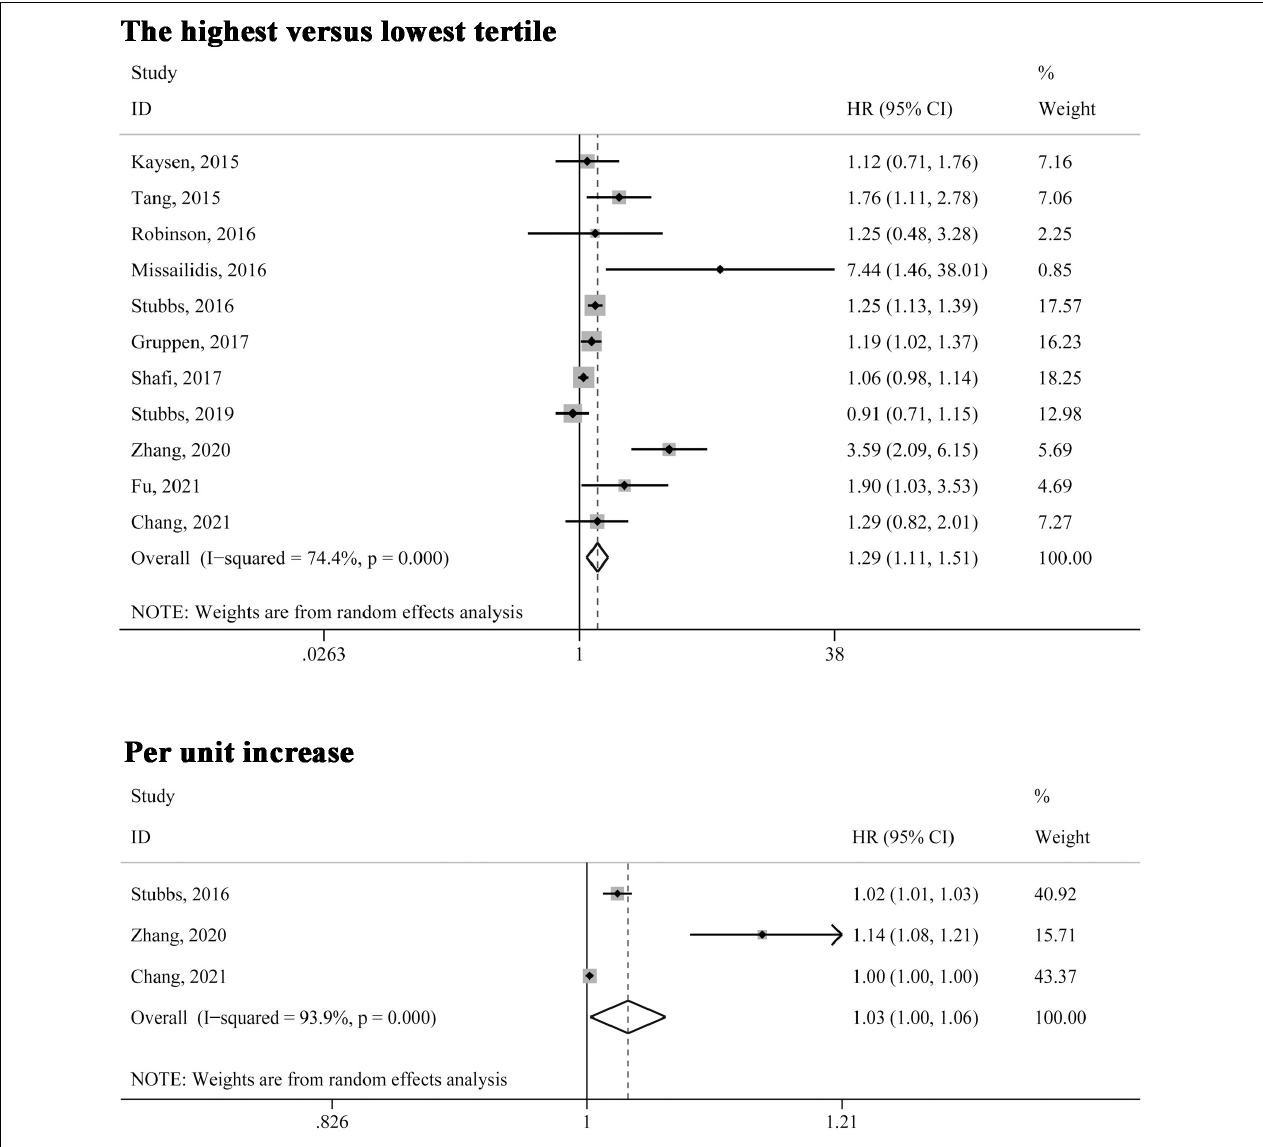
FIGURE 2 | Forest plot of the highest versus lowest tertile and per unit increase in TMAO levels and all-cause mortality risk. HR, hazard risk; CI, confidence interval.